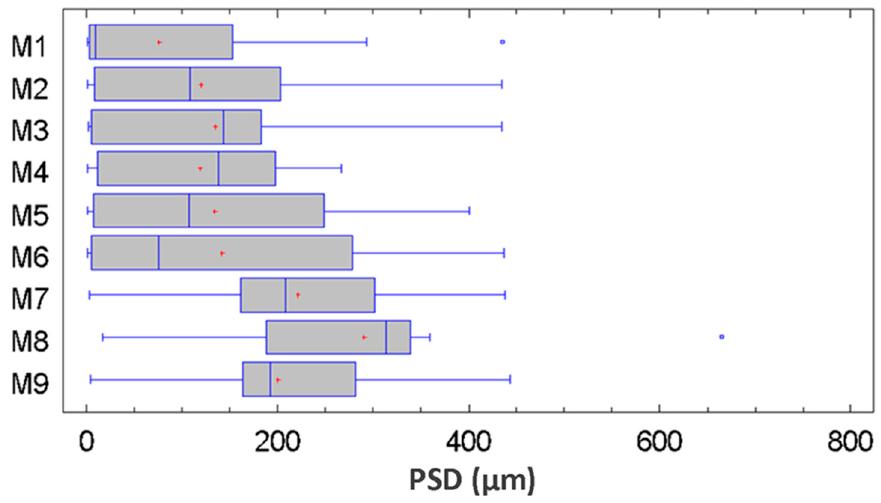
Figure 4. Box-and-whisker plot for the particle size distribution (PSD) of nine images obtained by optical microscopy.